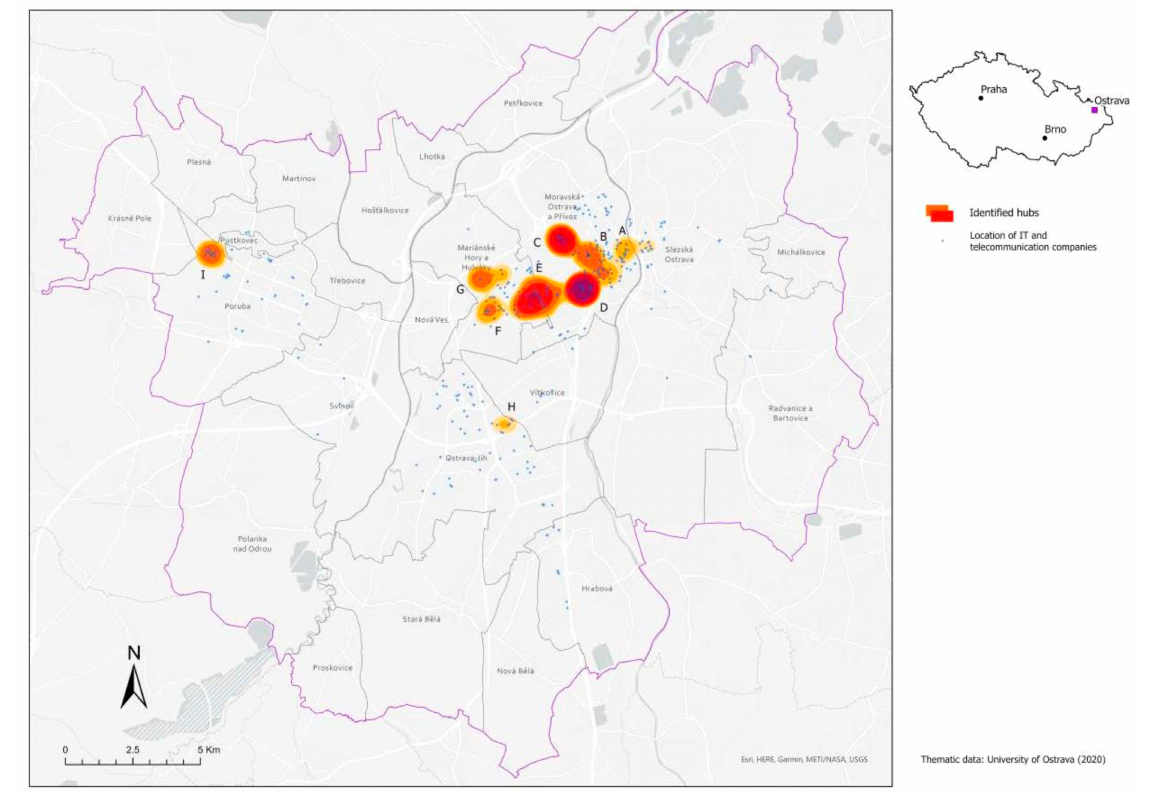
Figure 3. The locations of ICT hubs within the city of Ostrava.